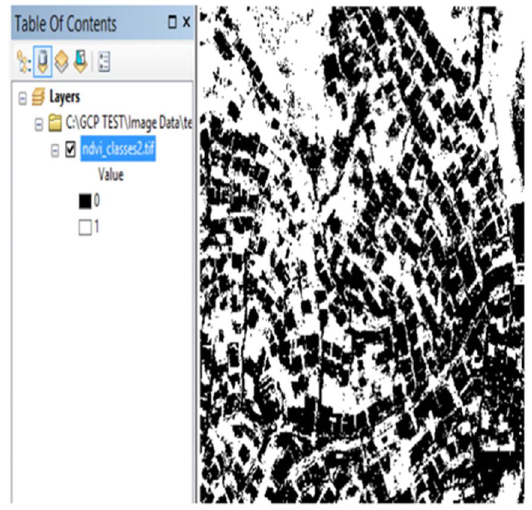
Figure 8: Shadow index image after thresholding. 4.2 NDVI The NDVI which is an index of plant greenness or photosynthetic activity has been used to distinguished pixels which belong to vegetation features on the digital image from those of other features by applying Equation 2 to calculate NDVI values of the digital image on a per- pixel basis. The output of this operation is a new image file (Figure 9) with NDVI values ranging from -1.0 to 0.989. The white pixels which have high NDVI values represent the vegetation features while the black or dark grey pixels which have low NDVI values represent the non-vegetation features.